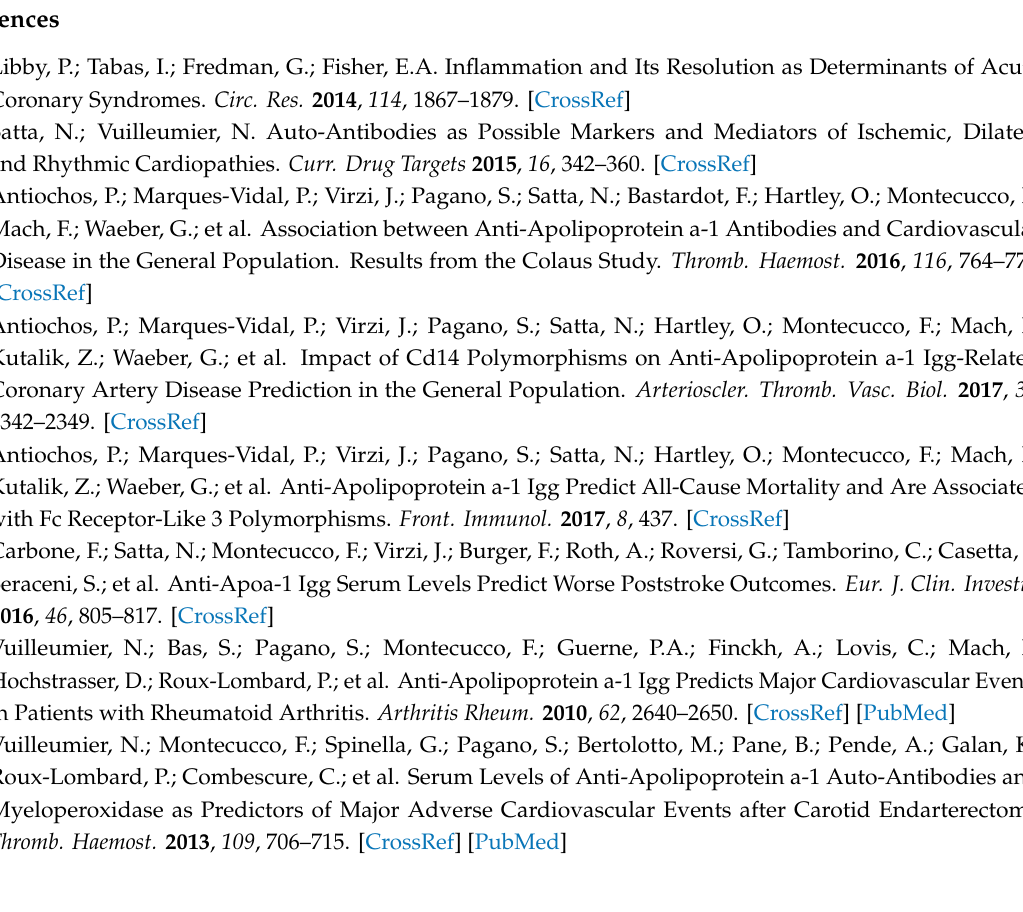
Figure S1: Anti-ApoA-1 IgGs don’t promote oxLDL uptake, Figure S2: ACAT-1 expression is not modulated by anti-ApoA-1 IgG, Figure S3: Summary of the anti-ApoA-1 IgG-mediated foam cell